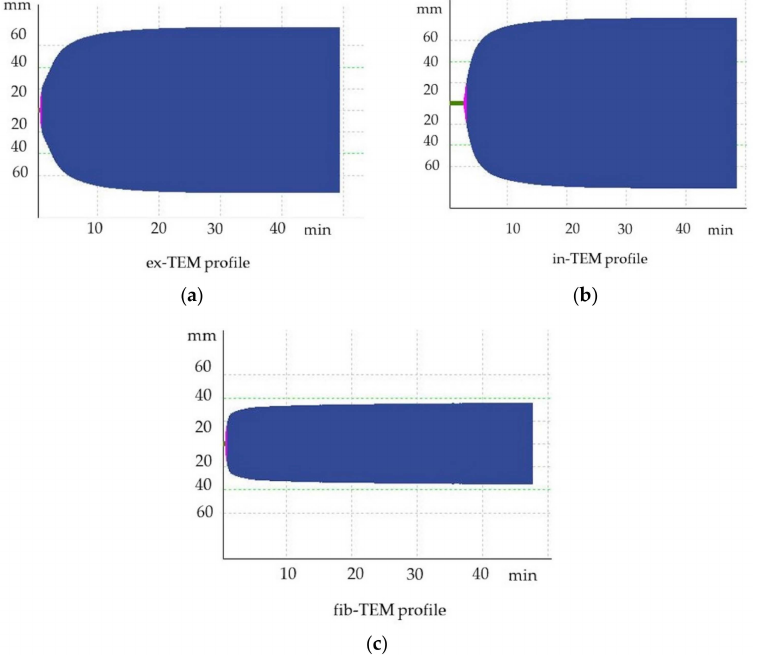
Figure 4. Hypercoagulable thromboelastometric tracing of a dog after bilateral maxillectomy for osteosarcoma (T1). ( a ) ex-TEM, extrinsic thromboelastometry pathway; ( b ) in-TEM, intrinsic throm- boelastometry pathway; ( c ) fib-TEM, functional